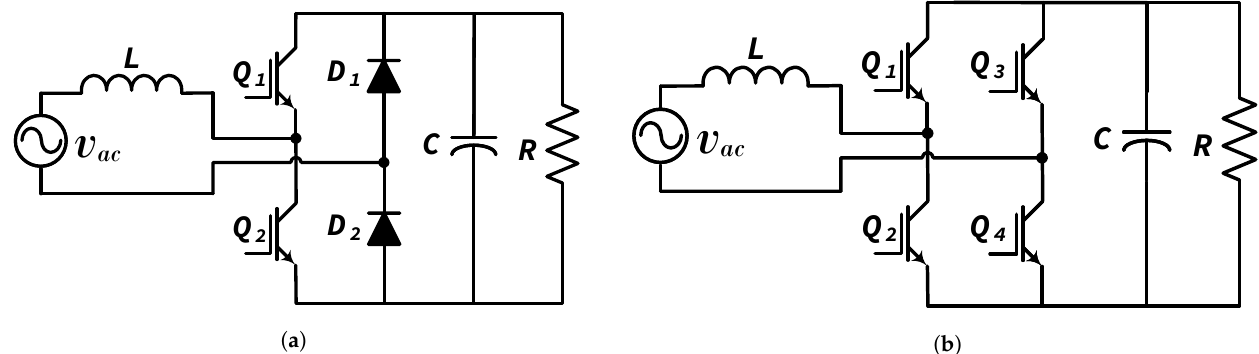
Figure 15. Conventional BBC or totem-pole converter: ( a ) line rectification with diodes; ( b ) line rectification with